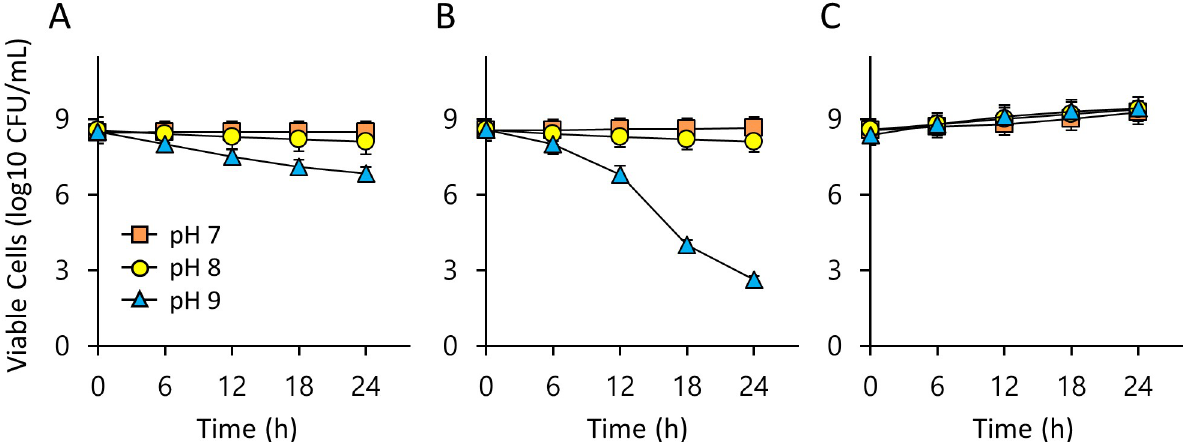
Fig 2. Survival of LAB at weak alkaline pH. Viable cells of L . lactis B103 (A), L . lactis B104 (B), and E . faecalis B105 (C) over time in MRS broth at pH 7, pH 8, or pH 9. Values are means of data from triplicate experiments each of which contained three technical replicates, with the standard deviation (SD) indicated by vertical bars.